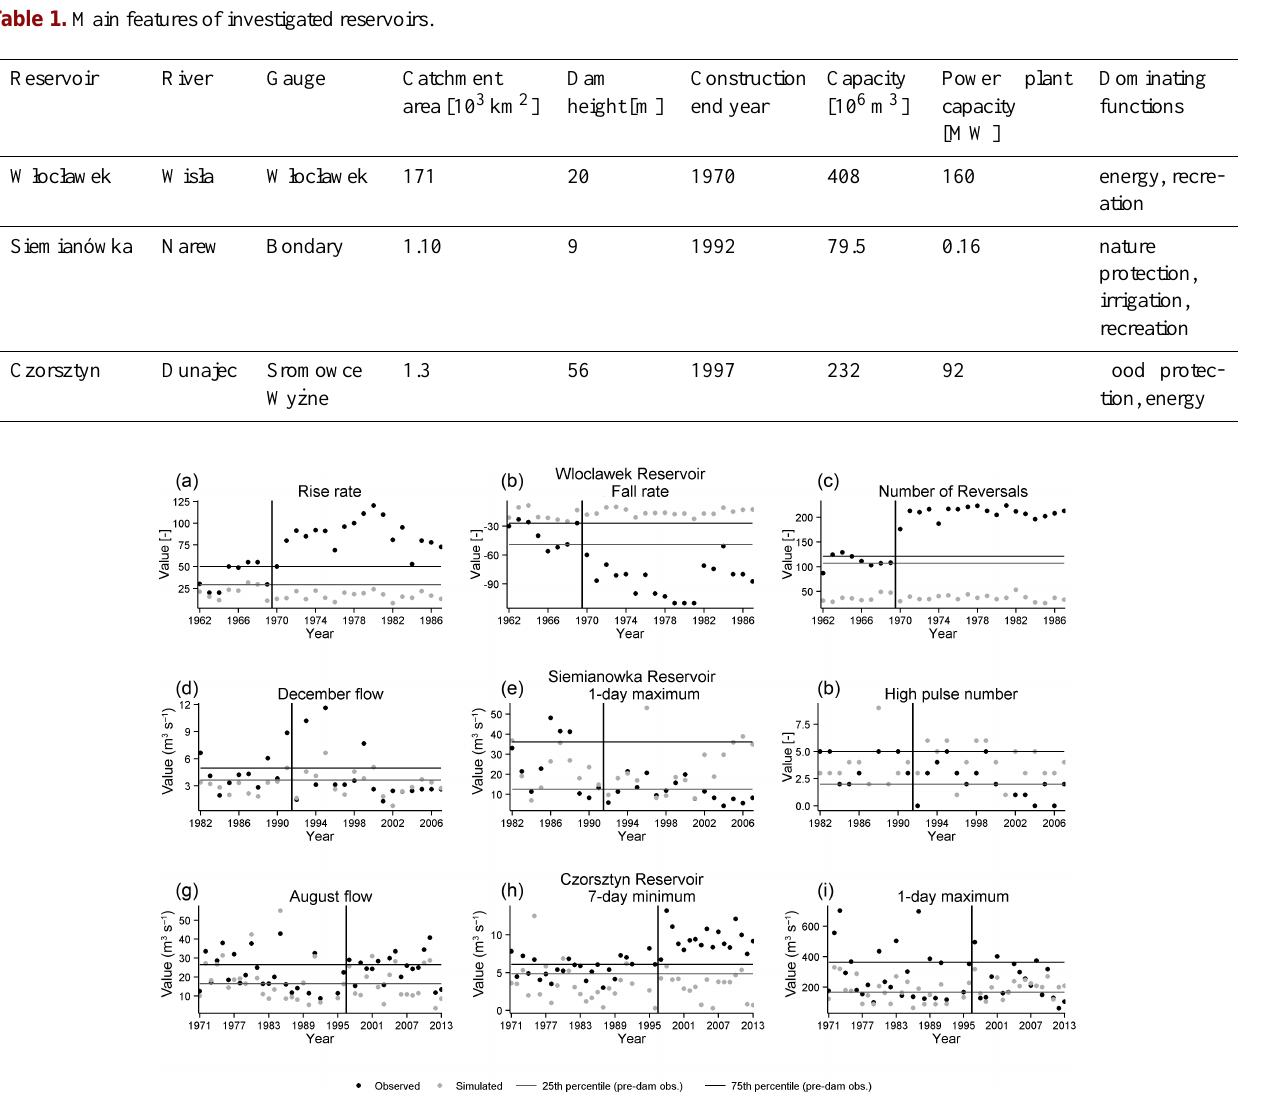
Figure 3. The effect of three dam reservoirs: Włocławek, Siemianówka and Czorsztyn on streamflow alteration assessed using observed and simulated flows. Black vertical line denotes the construction year of each reservoir. The 25th and 75th percentiles of the flow statistics were calculated based on pre-dam observed flows and delineate the likely interval of natural variability of a given